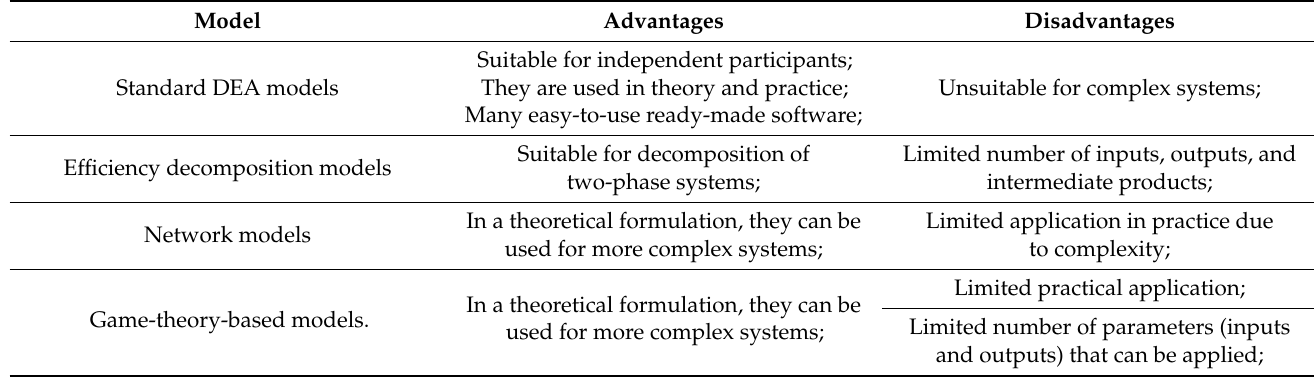
Table 1. Advantages and disadvantages of existing model in the